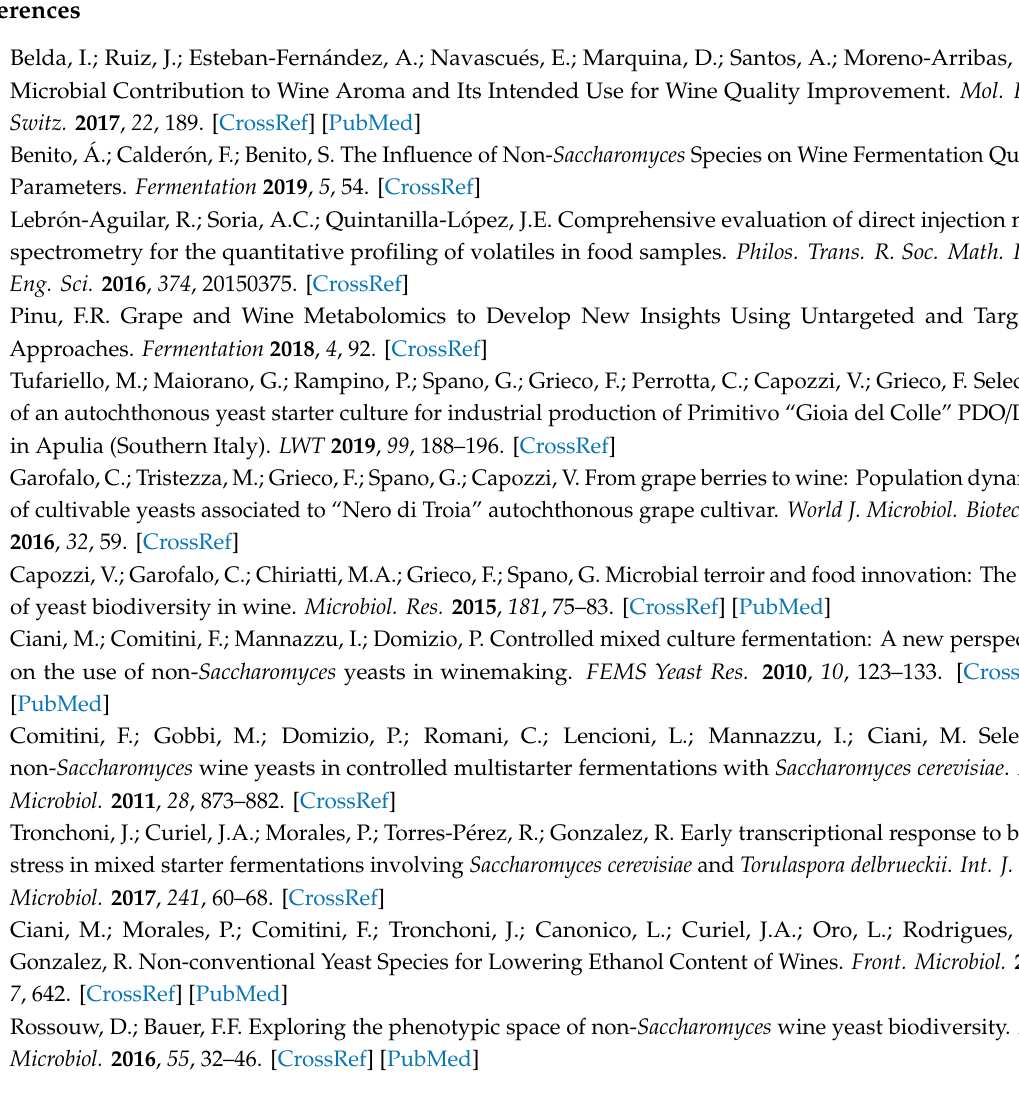
Figure S1: source file for Figure 2. Figure S2: source file for Figure 3. Figure S3: source file for Figure